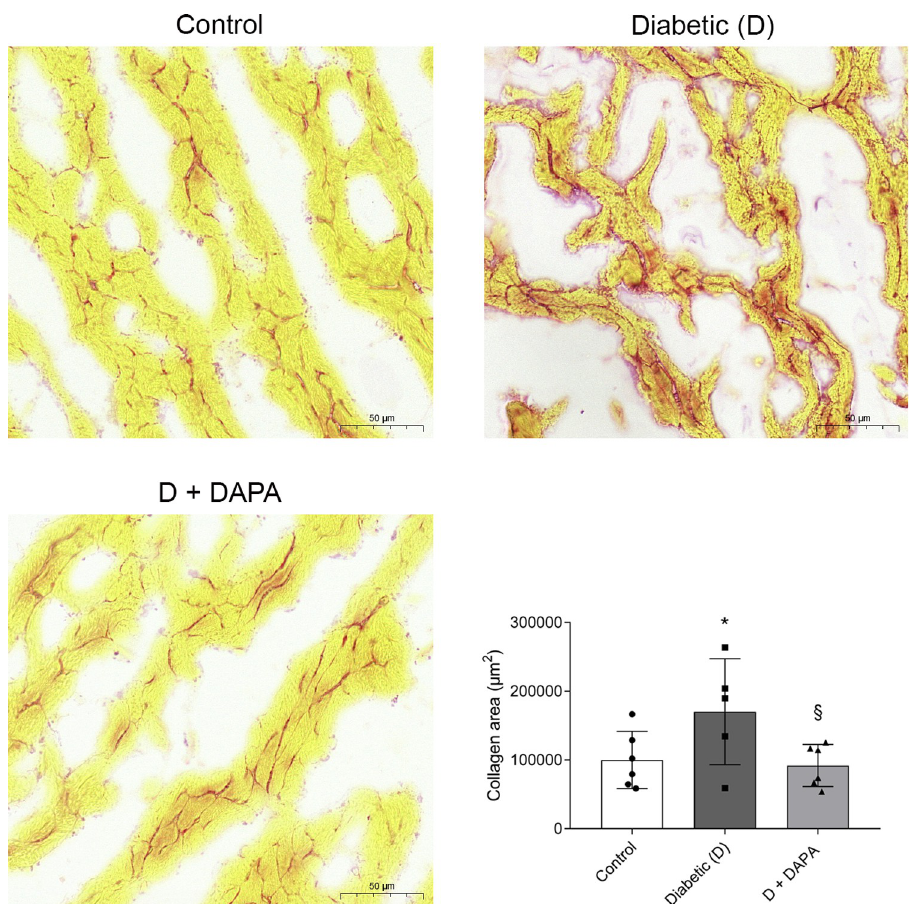
Fig 5. Diabetes-induced cardiac fibrosis is mitigated by DAPA treatment. Representative picrosirius red stained heart sections and quantitative evaluation of fibrosis of Control, diabetic (D) and dapagliflozin treated diabetic rats (D +DAPA). The red-stained area was measured based on the red color intensity. The myocardial field of measurement was manually selected with the caution of avoiding the endocardium and perivascular connective tissue. Original magnification, x400. Scale bar, 50 μ m. Bars indicate means ± SDs and data were analyzed by one-way ANOVA with Holm-Sidak multiple comparisons test (n = 5-6/group). � p < 0.05 vs . Control, §p < 0.05 vs . Diabetic.